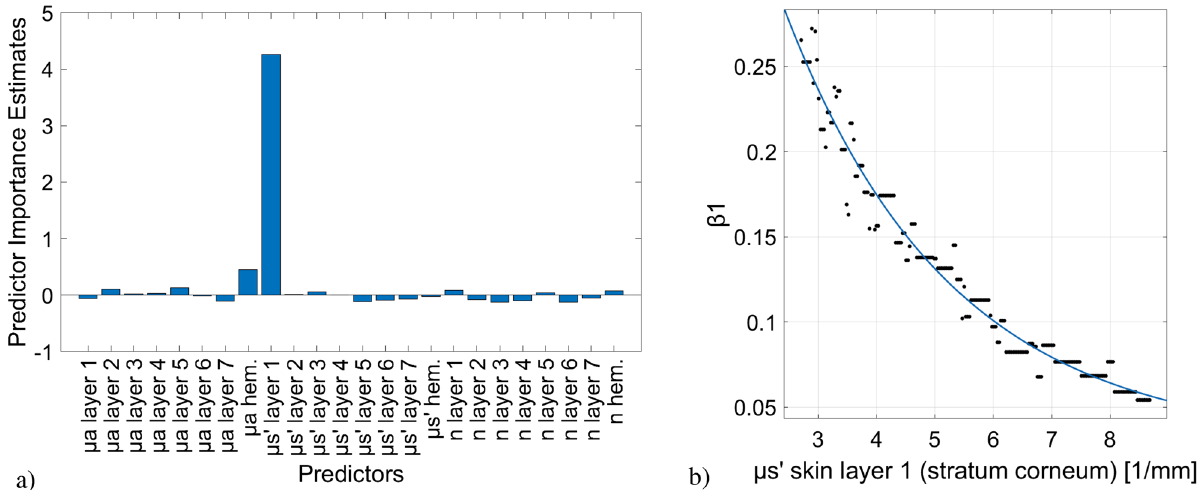
Figure 4. ( a ) Out-of-bag permuted predictor importance of the 24 optical properties values when taken as prediction parameters for the response β 1 in a RF approach. ( b ) Graphical representation of data sets for µ ′ s of stratum corneum (dots) and the exponential function fitted thereto (curve). The equation is as follows: ) + y = 0.5979 · exp ( − 0.3524 · µ ′ s sc